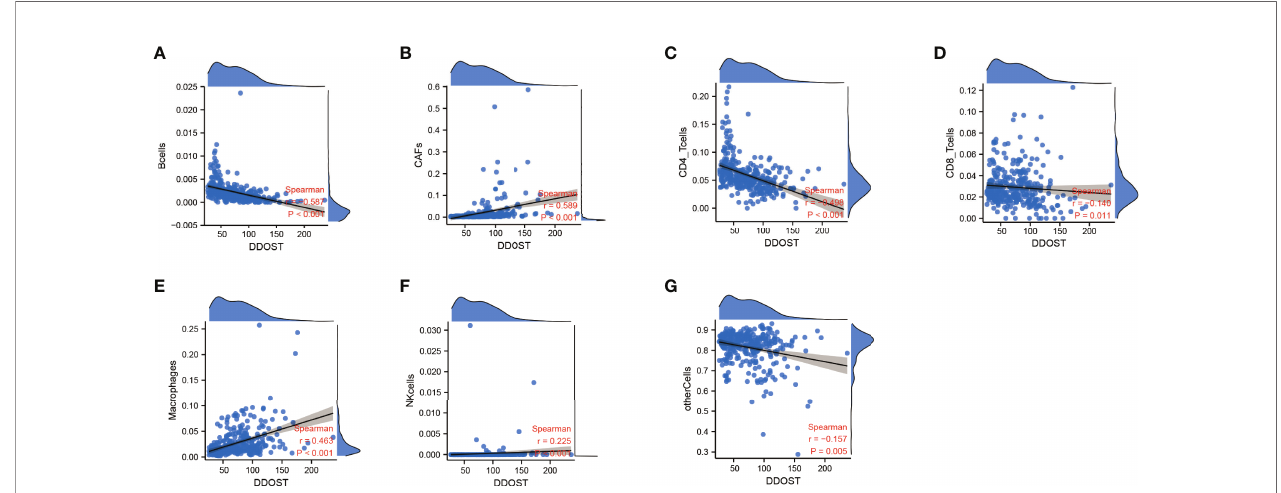
FIGURE 9 | The relationship between the expression of DDOST and immune cells were analyzed by EPIC. The scatter plot shows the correlation between DDOST and B cells (A) , CAFs (B) , CD4+ T cells (C) , CD8+ T cells (D) , macrophages (E) , NK cells (F) , and other cells (G) .